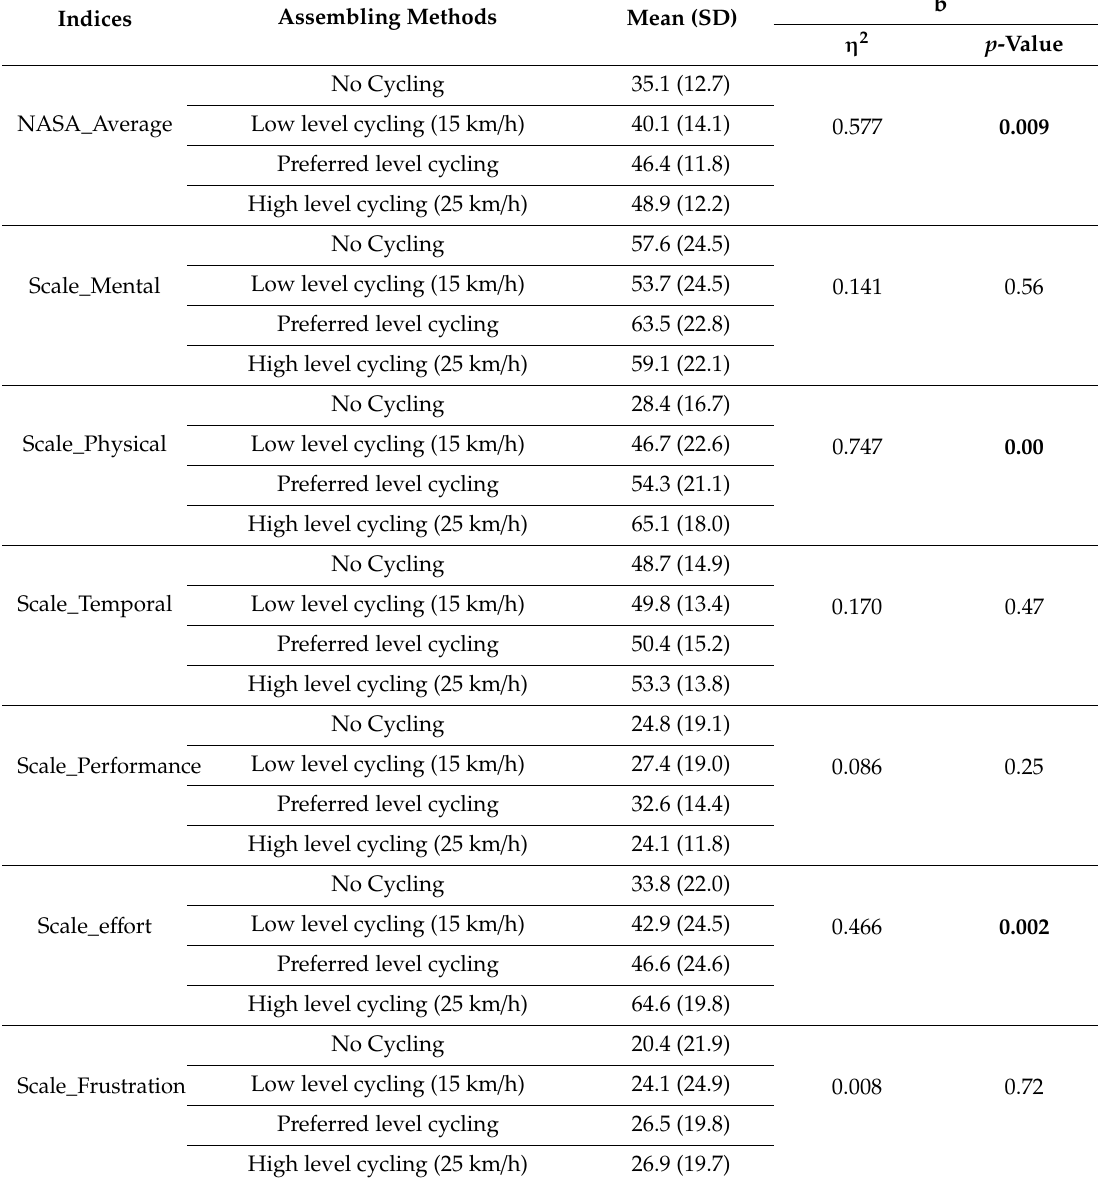
Table 2. Subjective workload